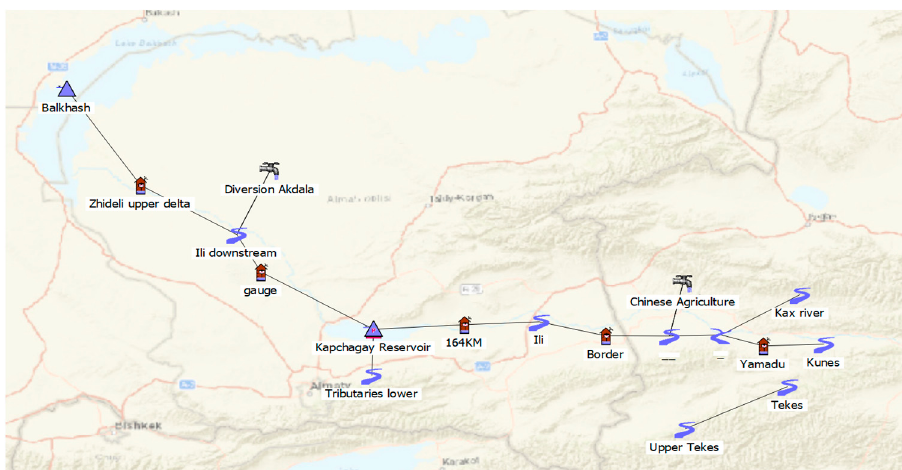
Figure 4. Schematic overview of RiverWare workspace of the Ili Basin model.